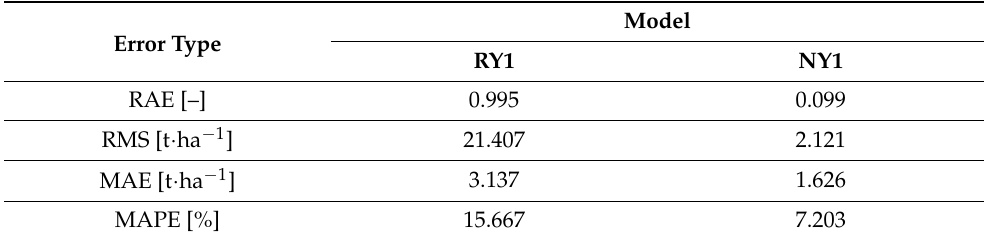
Table 4. Ex post predictive measures in models: RY1 and NY1.